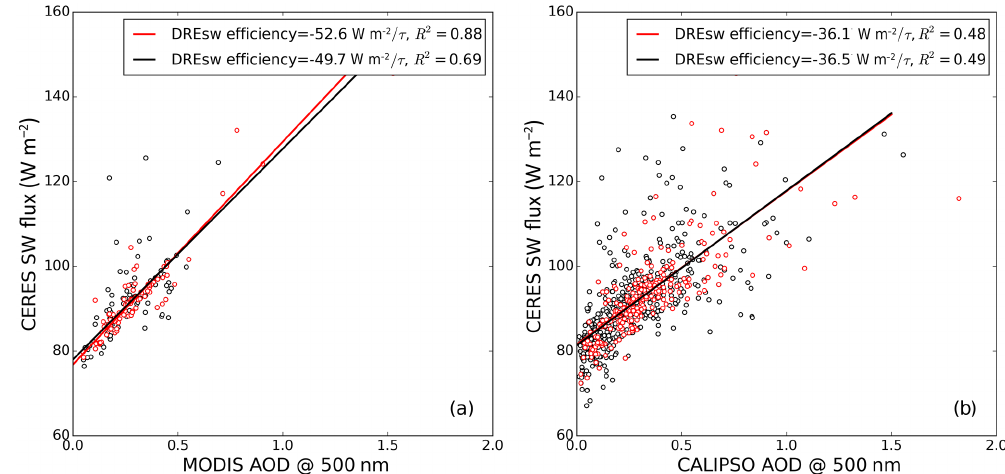
Figure 5. Linear regressions of CERES-measured upward SW flux at TOA with satellite-retrieved AOD for the selected cloud-free and dust- dominant cases. (Black points represent the cases selected using the CALIPSO cloud mask along the ground track and red points represent the cases selected using MODIS cloud mask over the entire CERES footprint.) Panel (a) shows the regression results based on MODIS AOD for cases (153 black points and 87 red points) with MODIS AOD retrievals. Panel (b) is for all cases (607 black points and 245 red points) with CALIPSO AOD